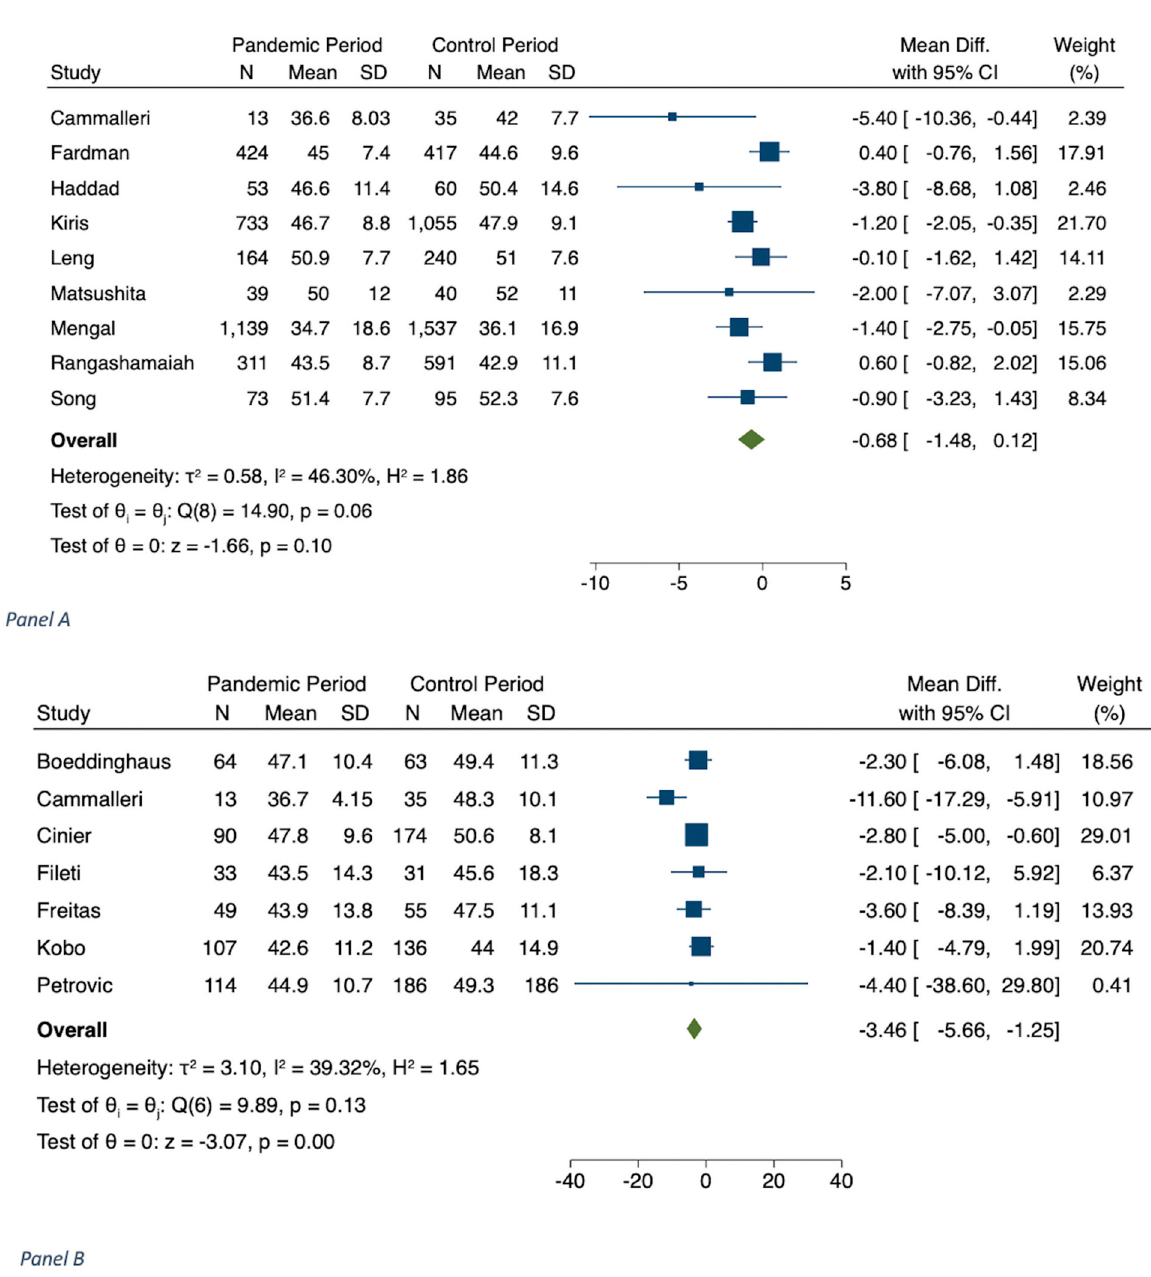
Figure 5. Panel ( A ): MD of LVEF (%) on hospital admission. Panel ( B ): LVEF (%) at discharge during COVID-19 pandemic in 2020 vs. corresponding control period.